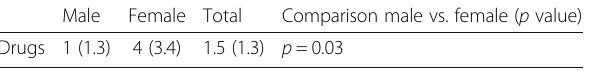
Table 4 Number of drugs used by autistic children with epilepsy Male Female Total Comparison male vs. female ( p